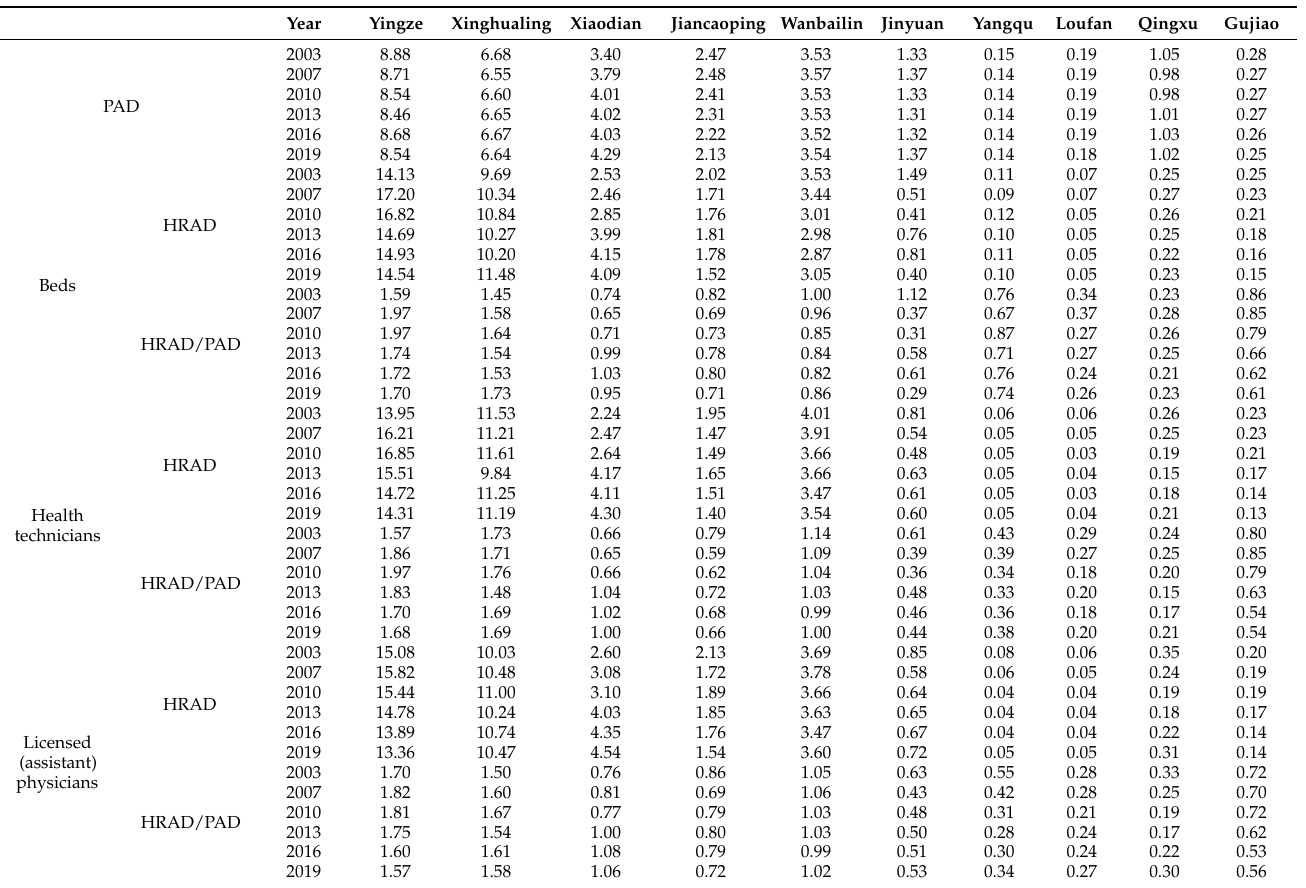
Table A1. Agglomeration degree of medical and health resources in districts and counties of Taiyuan,